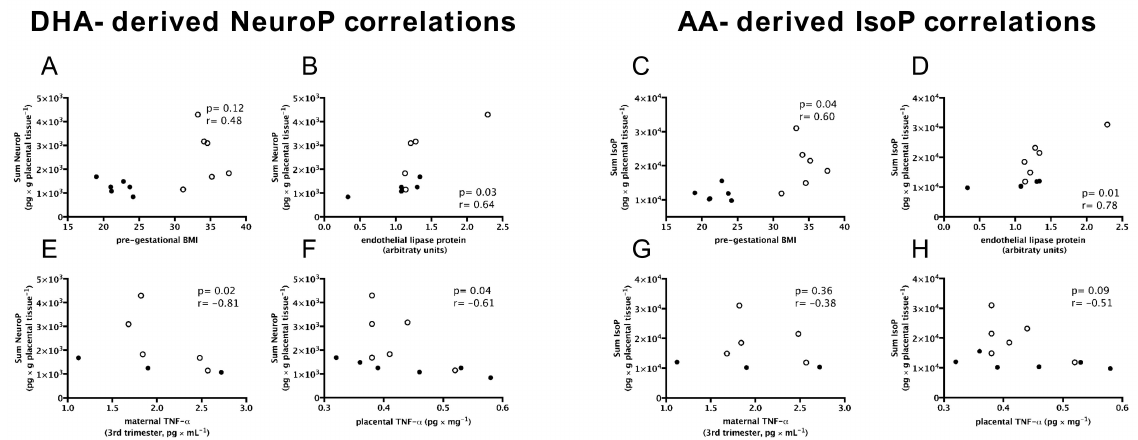
Figure 4. DHA-derived neuroprostanes are negatively correlated with inflammation markers, and AA-derived isoprostanes are positively associated with maternal pre-gestational BMI. Spearman rank correlations of DHA-derived neuroprostanes (NeuroP; A , B ) and AA-derived isoprostanes (IsoP; C , D ) and pre-gestational BMI and endothelial lipase, respectively, and DHA-derived neuroprostanes ( E , F ) and AA-derived isoprostanes ( G , H ) and maternal and plasma TNF- α , respectively. Placentas from lean women ( • ) and from obese women ( (cid:35)